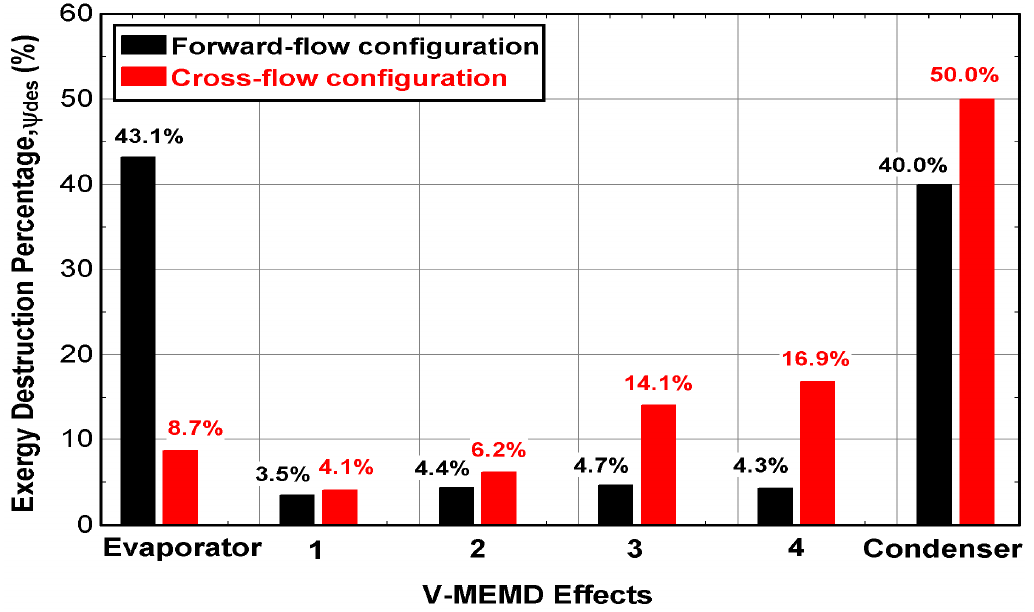
Figure 9. Exergy destruction percentage through the cascade effect of the V-MEMD unit . v H 1 = 900 L/h, T H 1 = 75 ◦ C, ( P v = 11.5